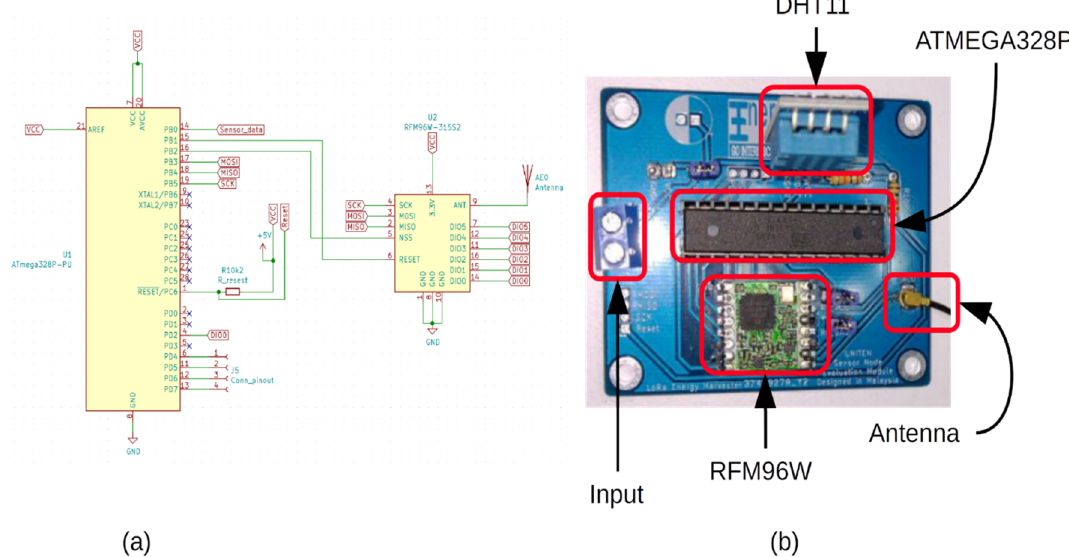
Figure 16. The designed WSTx where ( a ) is the circuit diagram and ( b ) is the actual design. Table 2. The current and voltage characteristics of the WSTx